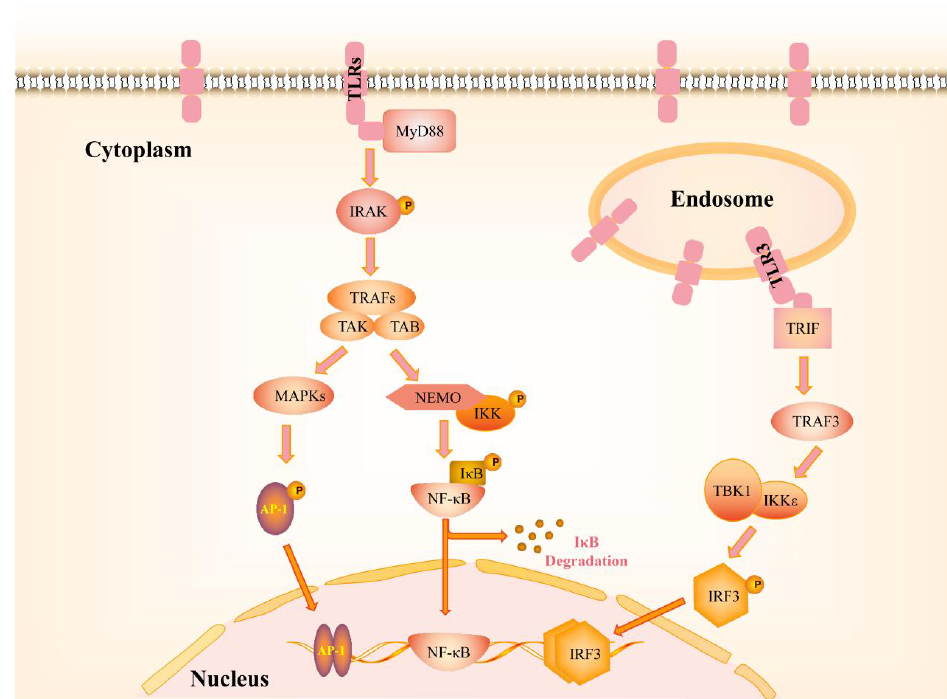
Figure 1. TLR-mediated intracellular signaling pathways. All of TLRs, except TLR3, initiate MyD88-dependent signaling pathways, activating NF- κB and MAPKs. TLR3 is located in the endosomal membrane and initiates the TRIF-dependent signaling pathway, mediating the production of pro-inflammatory cytokines and type I interferon. MyD88: myeloid differentiation primary response gene (88); IRAK: interleukin-1 receptor-associated kinase; TRAFs: TNF receptor-associated factors; MAPKs: mitogen-activated protein kinases; AP-1: activator protein 1; TRIF: TIR domain-containing adaptor inducing IFNβ; TBK1: TANK-binding kinase 1; IRF3: interferon regulatory factor 3.